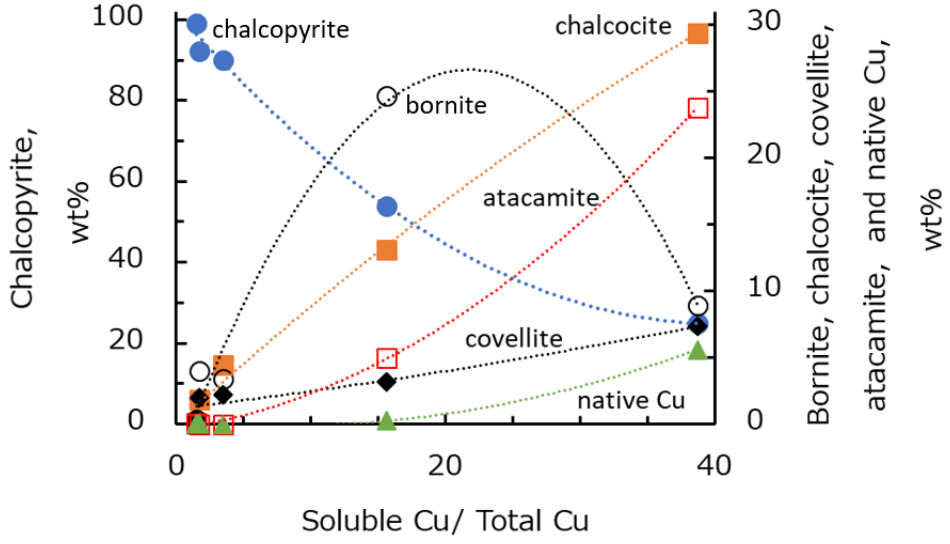
Figure 2. Relationships between copper oxidation degree and composition of copper minerals.